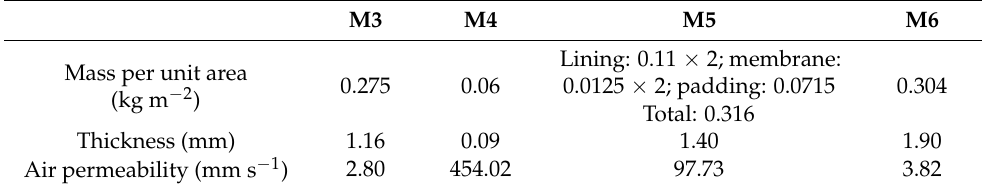
Table 1. Characteristic Data for the Textile Fabrics